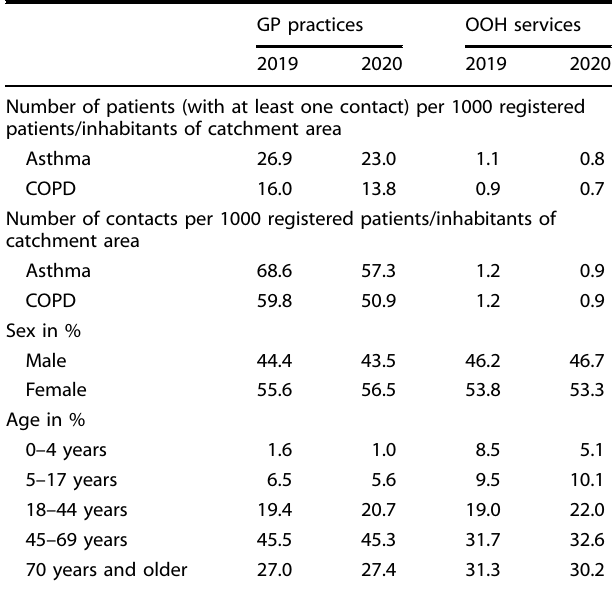
and Table 2. The proportion of home visits did not change signi fi cantly in 2020 compared to 2019.